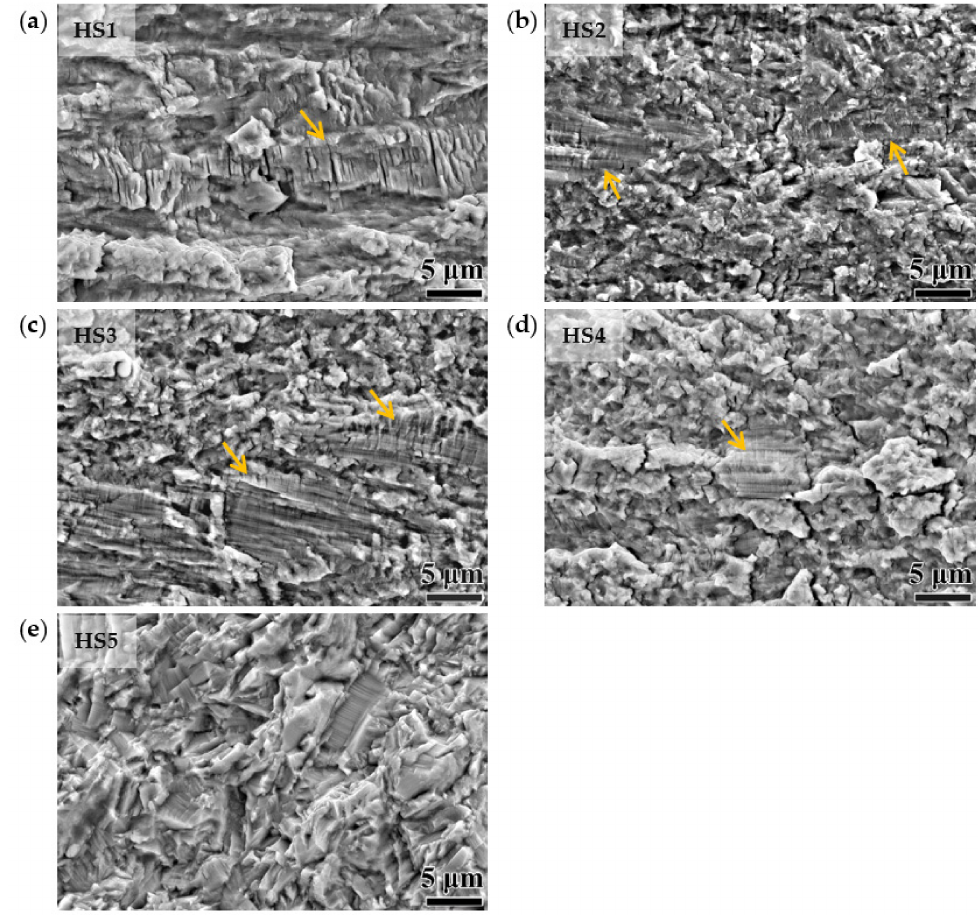
Figure 6. SE images of fracture surfaces of the different heterostructured specimens. ( a ) HS1, ( b ) HS2, ( c ) HS3, ( d ) HS4, and ( e ) HS5. The lamellar structures of the hard zones with fatigue striation were indicated by arrows in ( a – d